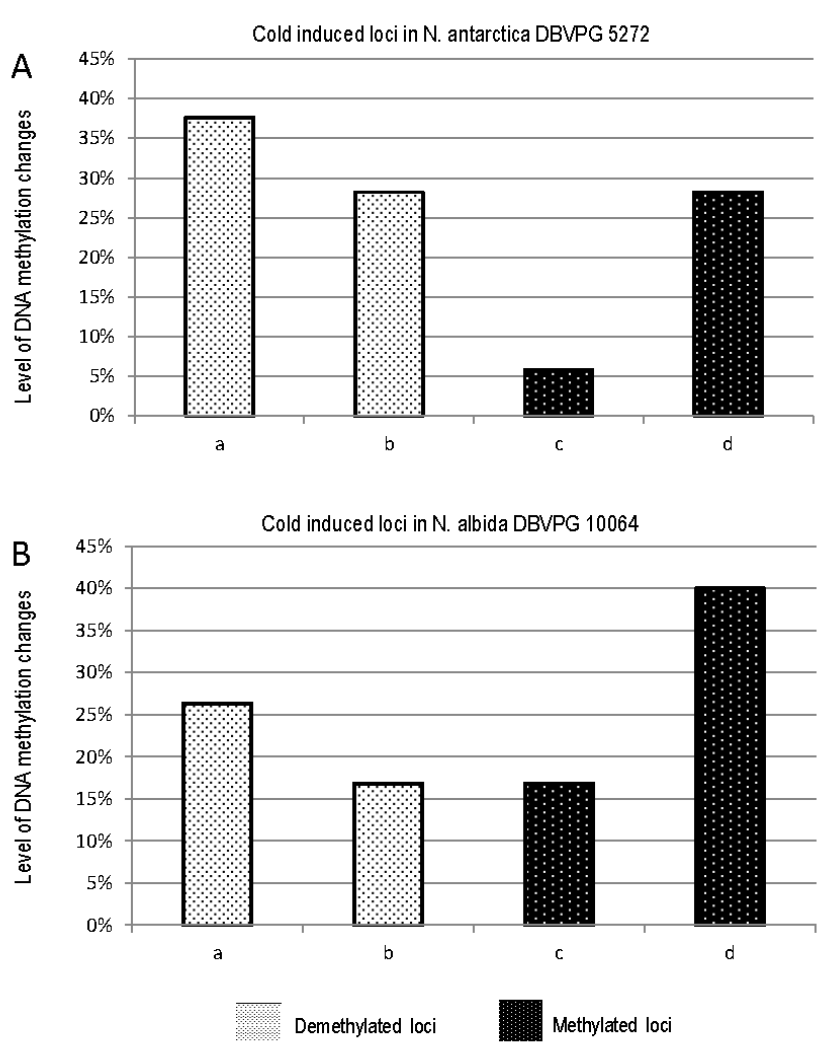
Figure 5. Demethylated and methylated loci of N. antarctica DBVPG 5271 ( A ) and N. albida DBVPG 10064 ( B ) induced by cold stress and changed (a,c) or unchanged (b,d) after recovery as in Table 2.